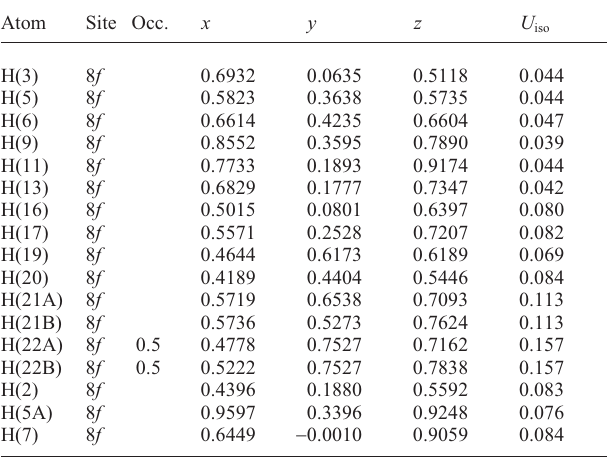
Table 2. Atomic coordinates and displacement parameters (in Å 2 )